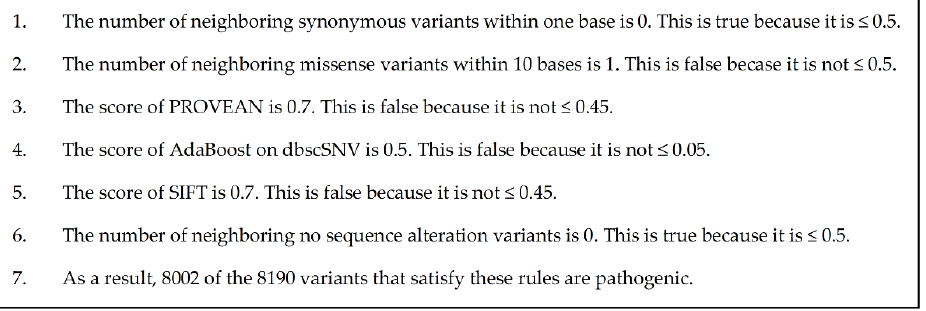
Figure 7. This figure is the result of human interpretation and writing of the path in the decision tree of MYO7A NM_000260.4(MYO7A):c.5618G>A (p.Arg1873Gln), circled in red in Figure 6, using information from the case study.